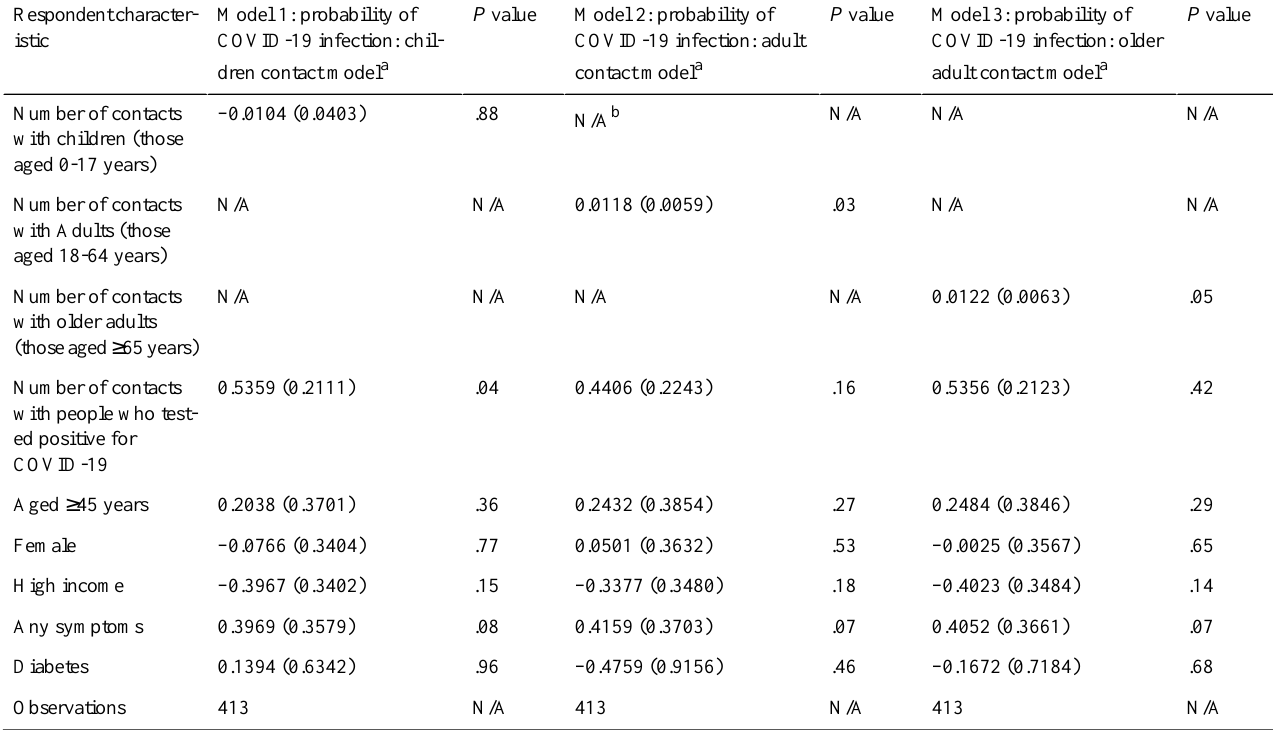
Table 2. Predicted probabilities of COVID-19 infection in Vermont between April 20 and May 13, 2020.